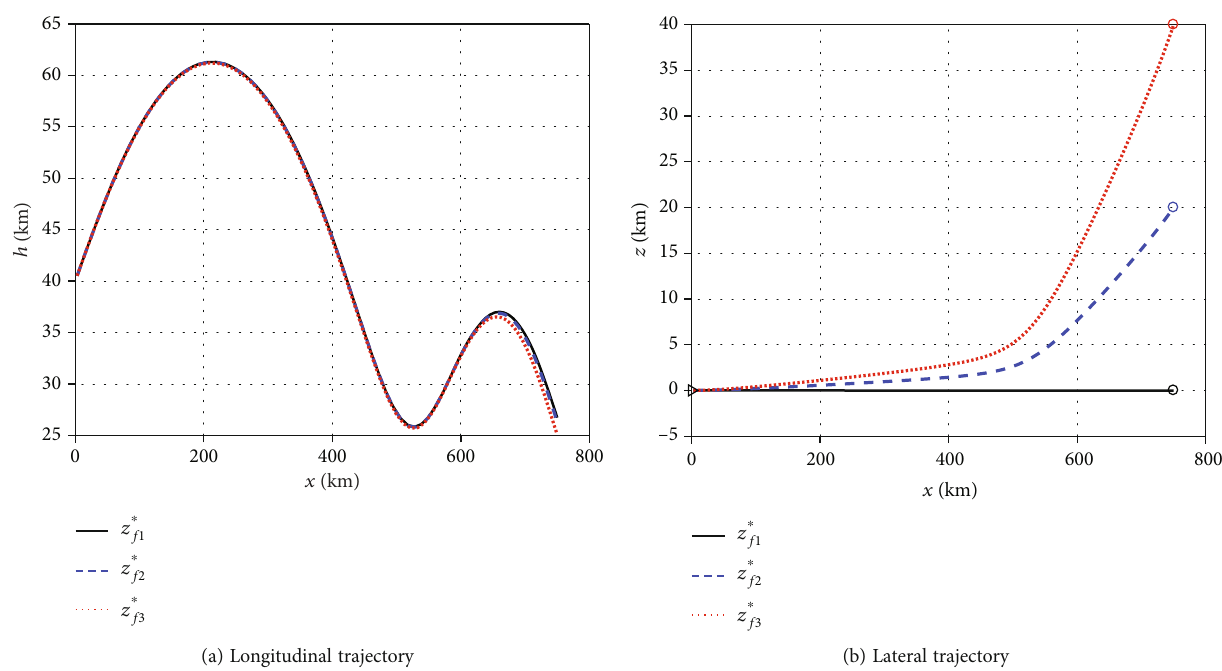
Figure 1: Three initial trajectories of di ff erent terminals. ⊳ represents the starting position of the trajectory. ○ represents the expected end position of the trajectory. The meaning is the same in the fi gure